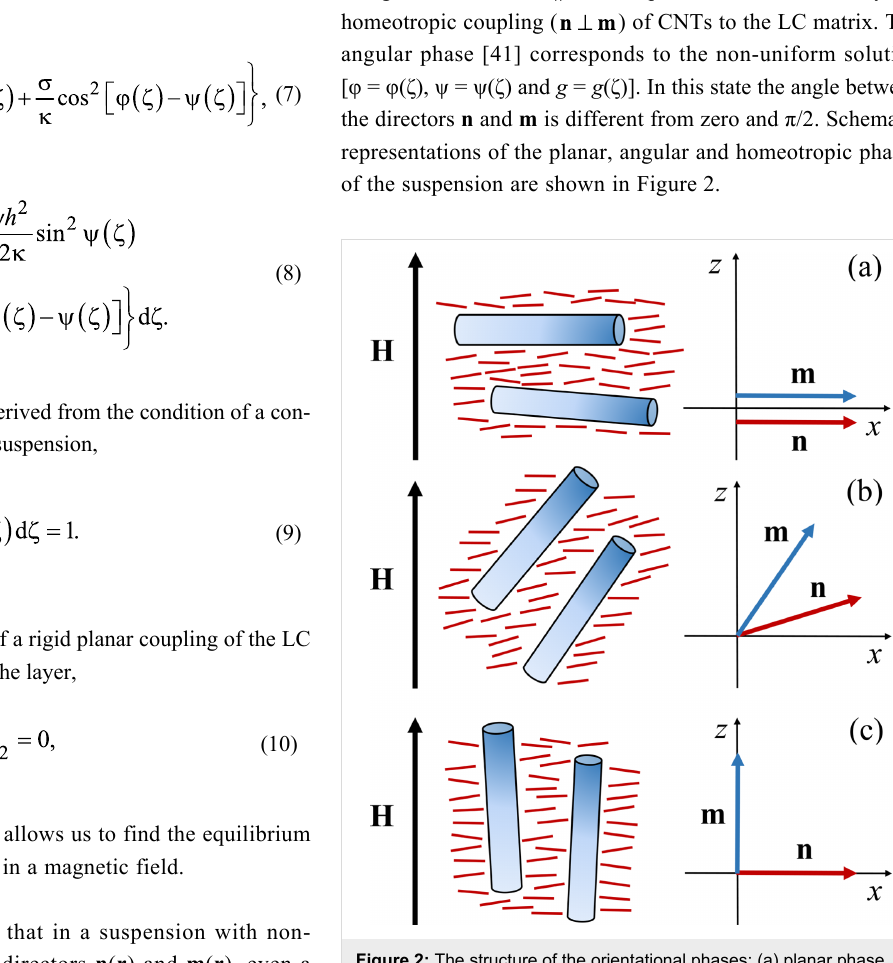
Under the influence of a magnetic field, the initial planar